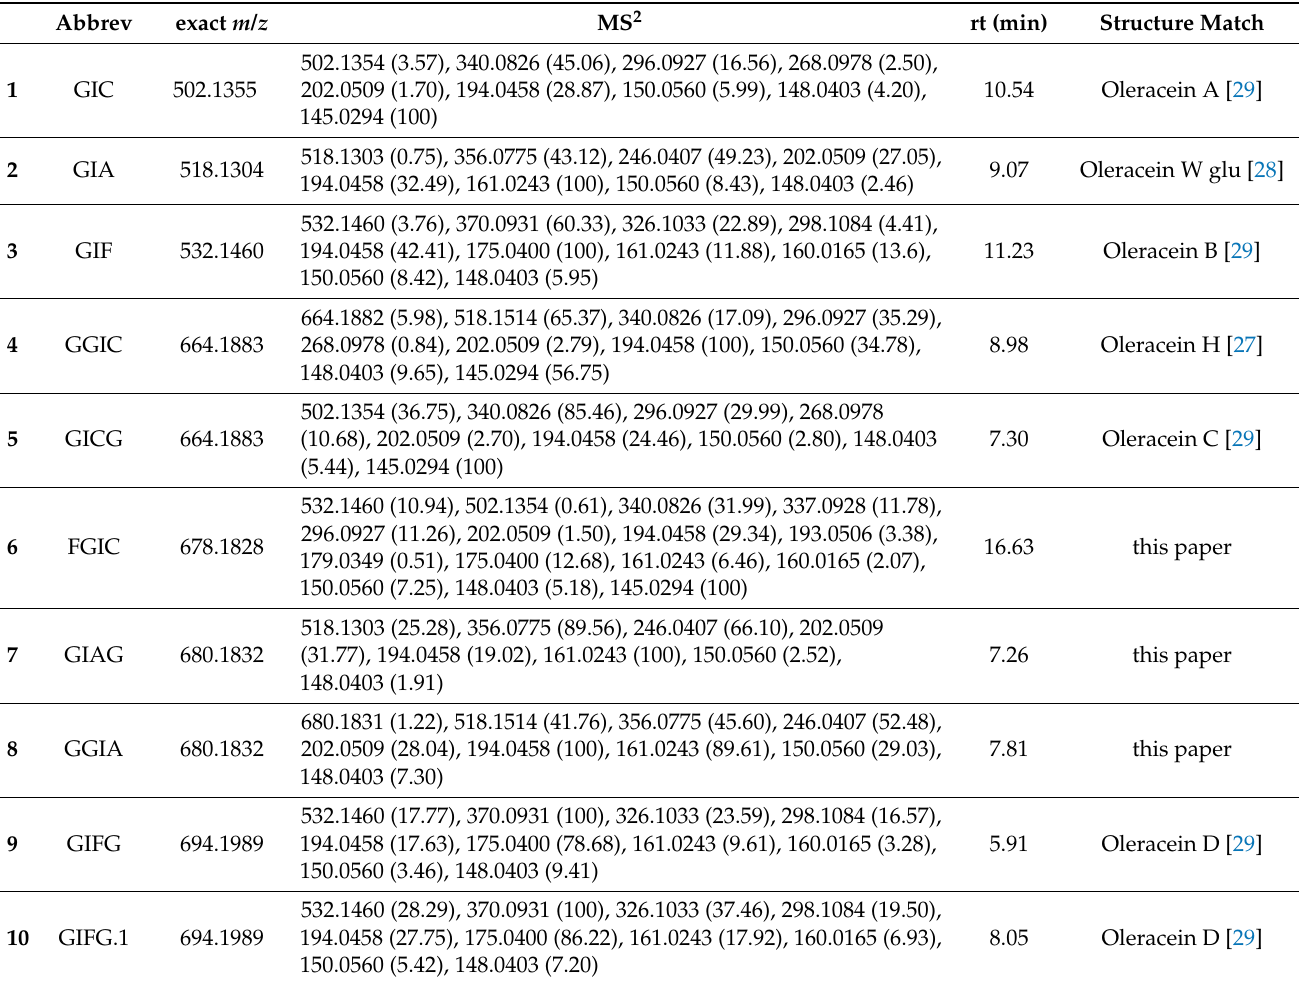
Figure 2. Total ion chromatogram (TIC) and extracted ion chromatogram (EIC) of the identified oleraceins. Oleraceins represent a major component of the hydromethanolic extract from purslane with very close normalization levels (NL) between TIC and EIC. Oleraceins eluted between the 5th and the 17th min. Table 3. Chromatographic and mass spectral features of the identified 51